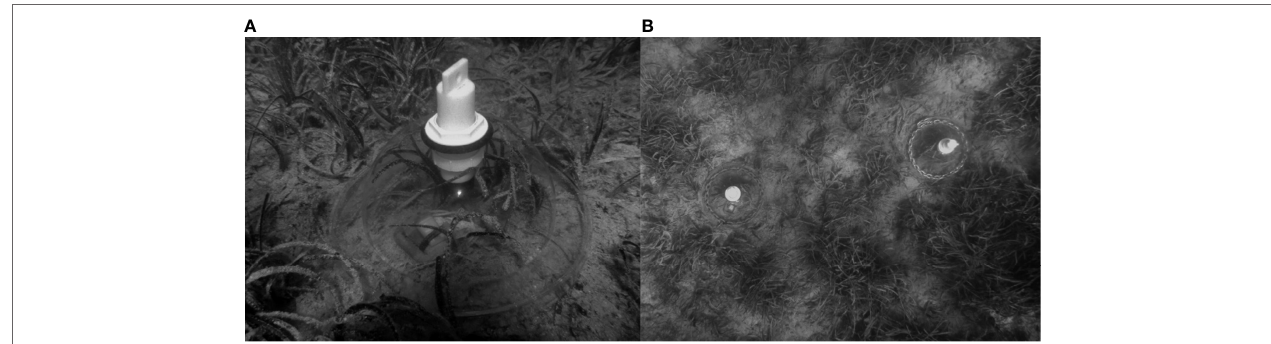
FIGURE 2 | Small benthic chamber setup (A) Deployed over short patchy P. oceanica habitat (B) Aerial view above patchy P. oceanica chambers deployed. Photographs; A and B © Jente van